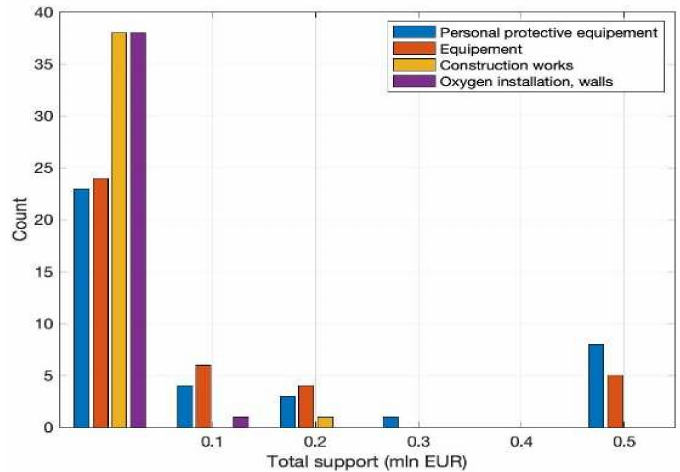
Figure 7. Support structure for COVID pandemic mitigation (values up to EUR 0.5 million).